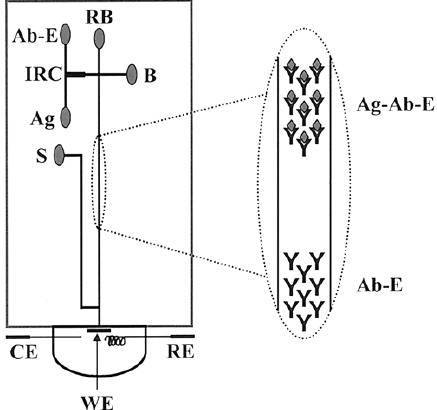
Figure 5. Schematic of the microchip-based electrochemical enzyme immunoassay. From Wang et al ., Anal. Chem . 2001 , 73 , 5323-5327. Reprinted with permission from ACS.